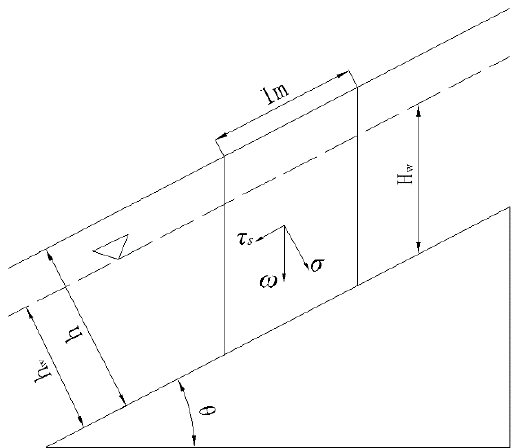
Figure 6. Force analysis of the accumulation in the gully.